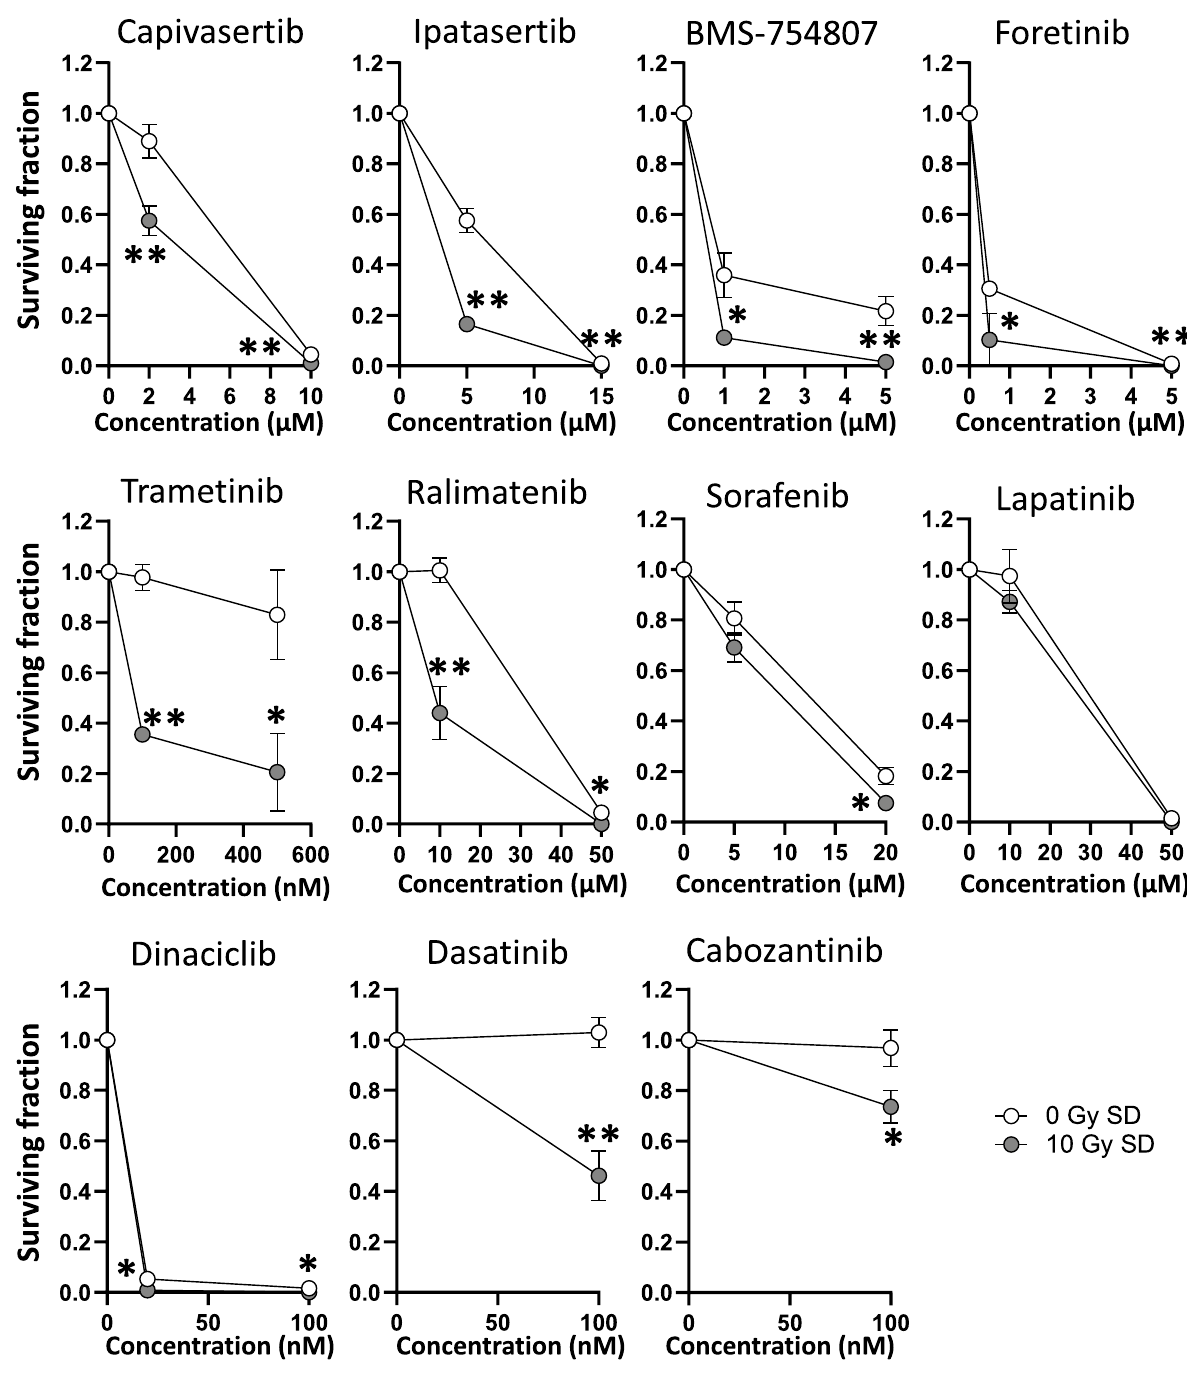
Figure 6. Long-term SD tumor cells are more sensitive to molecular inhibitors when the target has been activated by irradiation. PC3 cells were irradiated with a single dose (SD) of 10 Gy and cultured for 2 months. Unirradiated cells were used as control. Colony formation assays were used to determine sensitivity to molecular targeted drugs. At 24 h after plating, cells were incubated with inhibitors at indicated concentrations or DMSO (0.1%) for 24 h. Results show mean ± STDEV (n = 3, *P < 0.05, **P < 0.01, Student’s increased long-term phosphorylation and activation included the kinases AKT and MET. Elevated phospho- rylation of AKT promotes survival and radiation resistance and is a negative prognostic marker for poor clini- cal outcome in prostate cancer patients 20–22,53,54 . Combined treatment with the AKT inhibitor Ipatasertib and abiraterone significantly increased progression-free survival of metastatic castration-resistant prostate cancer patients compared to abiraterone alone especially in patients with PTEN-loss tumors and activated PI3K/AKT signaling 55 . Similar results were found in a randomized phase II trial examining AKT inhibition with Capivasertib